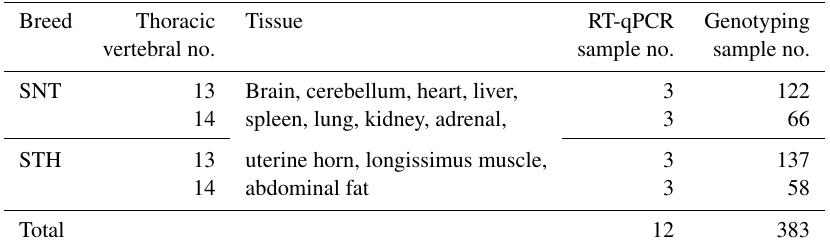
Table 1. Sample information of the real-time quantitative polymerase chain reaction (RT-qPCR) and genotyping. Breed Thoracic Tissue RT-qPCR Genotyping vertebral no. sample no. sample no. SNT 13 Brain, cerebellum, heart, liver, 3 122 14 spleen, lung, kidney, adrenal, 3 66 STH 13 uterine horn, longissimus muscle, 3 137 14 abdominal fat 3 58 Total 12